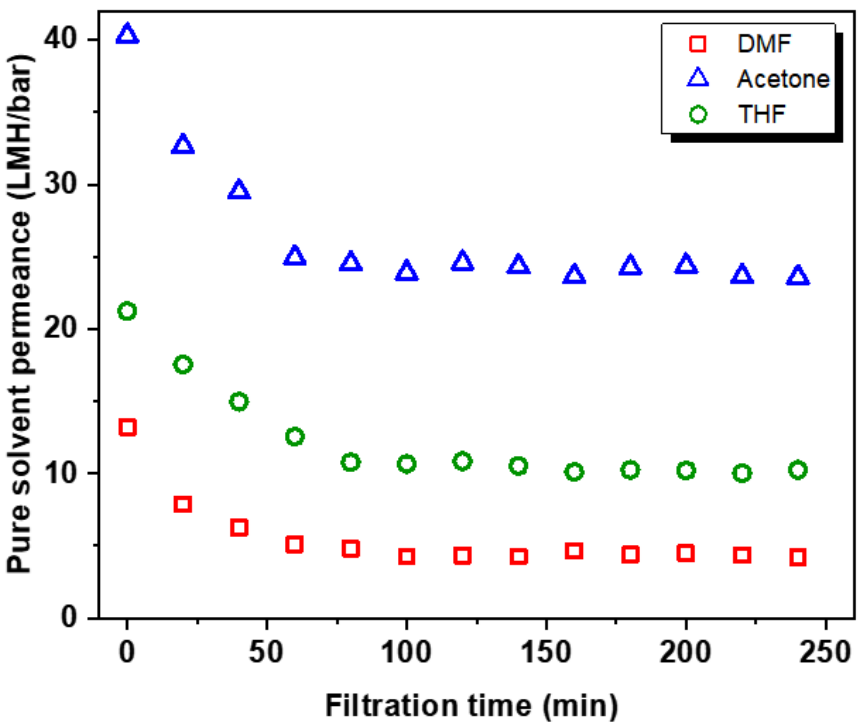
Figure 5. Initial permeation profiles of pure solvents including DMF, acetone, and THF through the crosslinked PBI membranes measured at 10 bar and room temperature. Unmodified PBI membrane was not testable due to its instability.